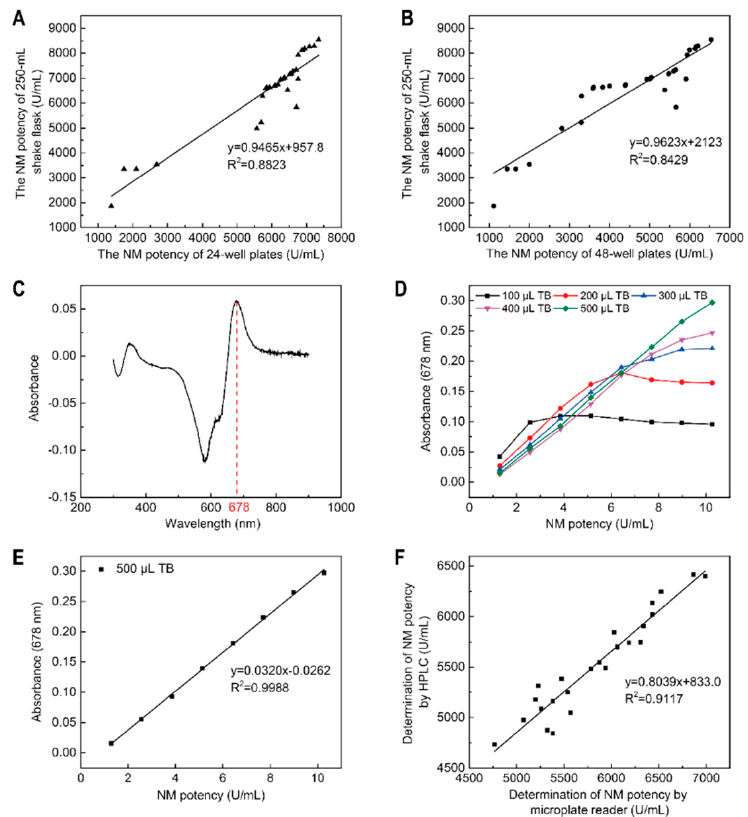
Figure 4. Optimization of the rescreening method for high-producing NM mutant strains. ( A ) Fermentation correlations between 24-deep well plates and 250 mL shake flasks; ( B ) Fermentation correlations between 48-deep well plates and 250 mL shake flasks; ( C ) A full-wavelength scan of TB and NM reaction solutions; ( D ) The influence of different TB volumes (1.0 × 10 − 4 mol/L) on the absorbance at different NM standard potencies; ( E ) A NM standard curve; ( F ) Correlations between TB spectrophotometry using a microplate reader and HPLC for NM potency determination.